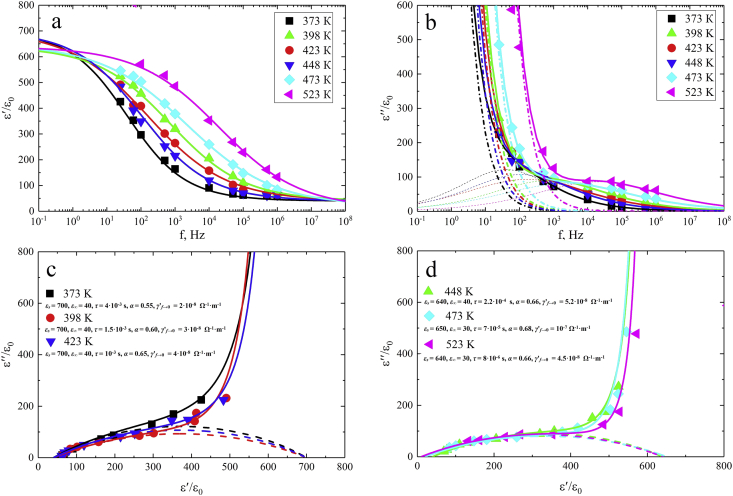
Dependences of ε'/ε0(f) (a), ε''/ε0(f) (b) and ε''/ε0 (ε'/ε0) (c, d) in the 0.7NaNbO3 – 0.3Ca2Nb2O7 solid solutions at 370–520 K (markers). The solid lines correspond to the calculation results for the case taking into account the contribution of the singular term. The dashed lines correspond to the calculation results without taking into account the contribution of the singular term.